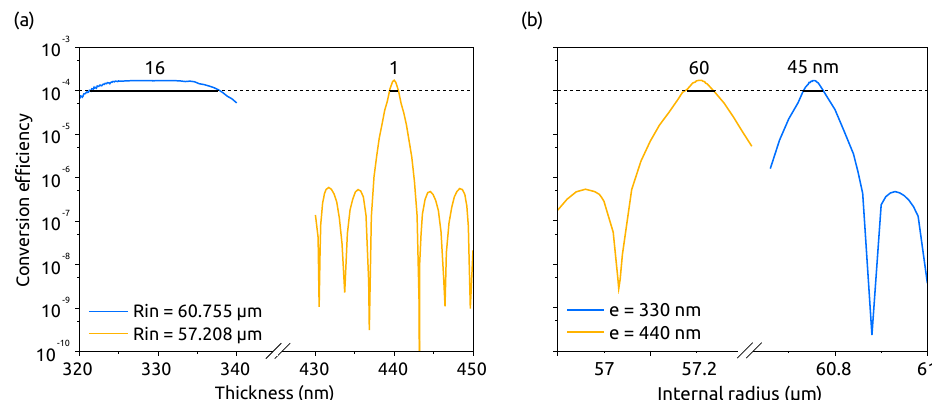
Figure 6. SHG conversion efficiency as functions of thickness e ( a ) and internal radius R in ( b ). The blue line corresponds to the maximum of Figure 5 where the highest efficiency was obtained for R in = 60.755 µ m and e = 330 nm. The orange line corresponds to the point R in = 57.208 µ m and e = 440 nm. The vertical axis is the same in both cases. The waveguide width is w = 800 nm and the pump power P in = 1 mW. The black lines indicate the ranges for which η ≥ 10 − 4 . In ( a ) η ≥ 10 − 4 in a range of only 1 nm for the yellow line, and in a range of 16 nm for the blue one, showing a robustness against fabrication defects of this geometry. In ( b ) η ≥ 10 − 4 in a range larger than 40 nm for both the geometries, showing that the conversion efficiency is not affected in a critical way by variations in the internal radius of the